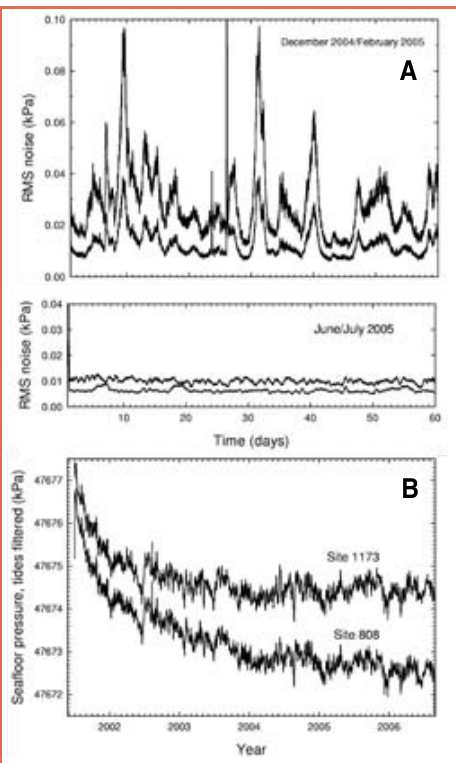
Figure 2. Indications of high recording fidelity from oceanographic signals. [A] Typical RMS high- frequency (<5 min period) seafloor- and formation- pressure signal levels at ODP Site 1026 in stormy and calm periods. Short bursts of high amplitudes in late December are teleseismic in origin (e.g., Fig. 5a). [B] Seafloor pressure records from ODP Sites 808 and 1173 (filtered to eliminate tidal